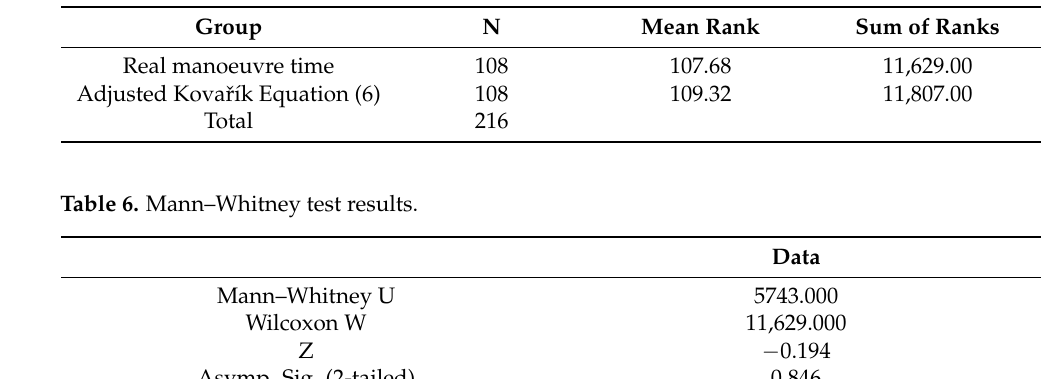
Table 5. Mann–Whitney test results.